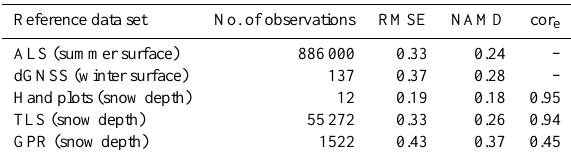
Table 4. Overview of the accuracy measures calculated from the different reference data sets.